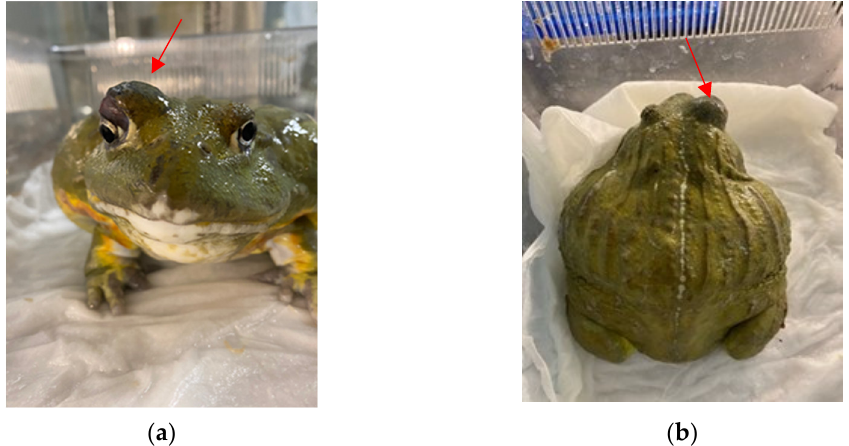
Figure 1. Cutaneous nodule deforming the upper profile of the right orbit: frontal ( a ); and dorsal ( b ) view.